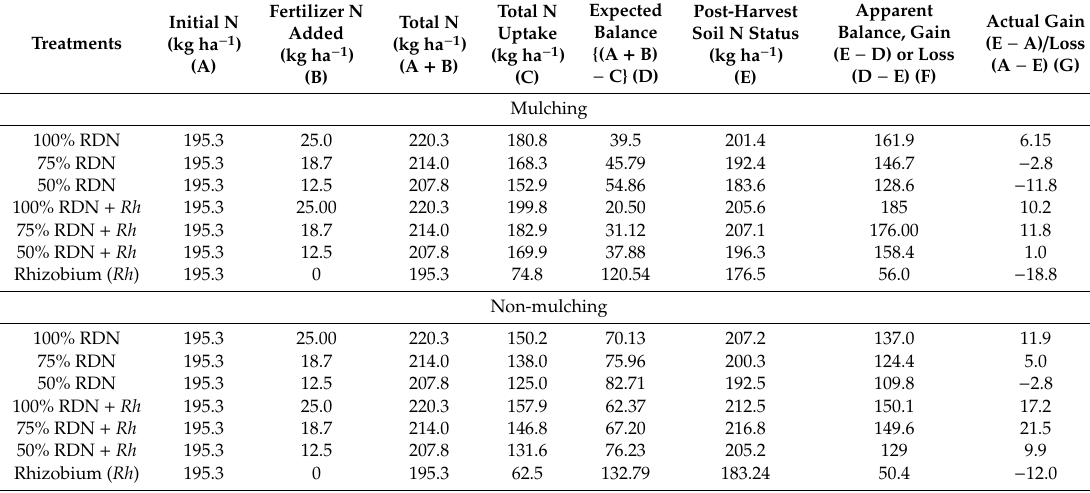
Table 4. Nutrient balance of peanut under di ff erent mulch and nutrient management practices (2015–2016).